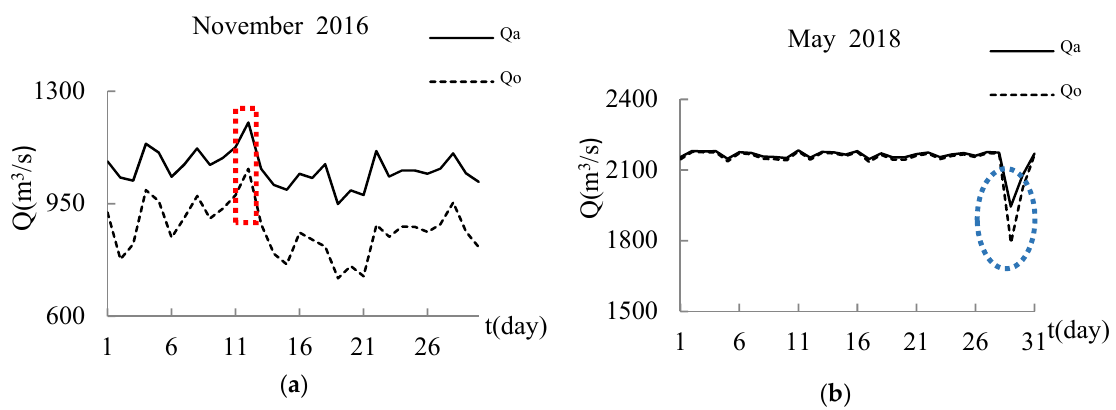
Figure 3. Actual and optimal power generation flow chart for November and January 2016.